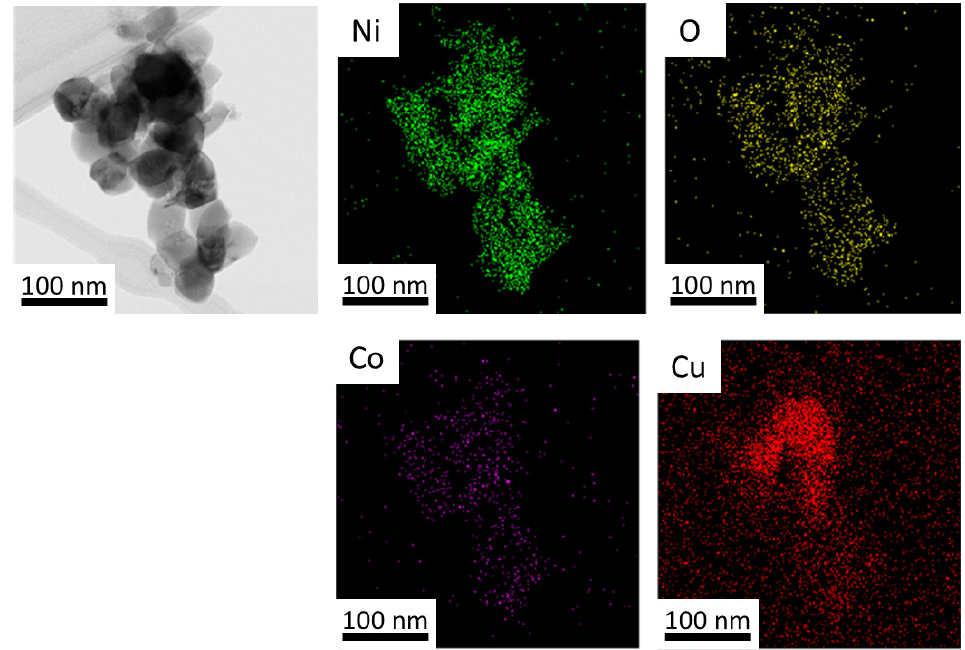
Figure 9. TEM bright-field image and elemental mapping of the co-formed ternary nanoparticle aggregate of metallic powder: 10Cu–80Ni–10Co (reduction at 300 ◦ C/30 min). Figure 10 is a TEM bright/dark-field image and diffraction pattern of the co-formed ternary powder (10Cu–80Ni–10Co). It is a composition of a bright field (BF/TEM) image of a robust single particle (reduction at 600 ◦ C), probably resulting from smaller particles’ coalescence; two central dark field (CDF) images taken under slightly different incident electron beam/particle angles; as well as the corresponding electron diffraction patterns of the same particle. While the BF image mostly reveals the particle size, morphology and some diffraction contrast effects showing bend contours and some mass/thickness contrast effects, the CDF images bring additional